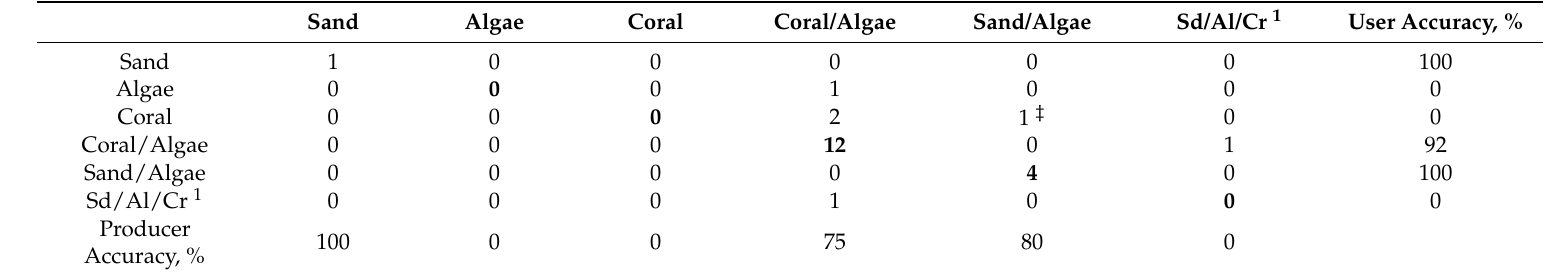
Table 6. Error matrix for the PRISM image of Heron Reef using HOPE-LUT. The overall accuracy for HOPE-LUT is 74%. The diagonals of this matrix are pixels correctly classed and are presented in